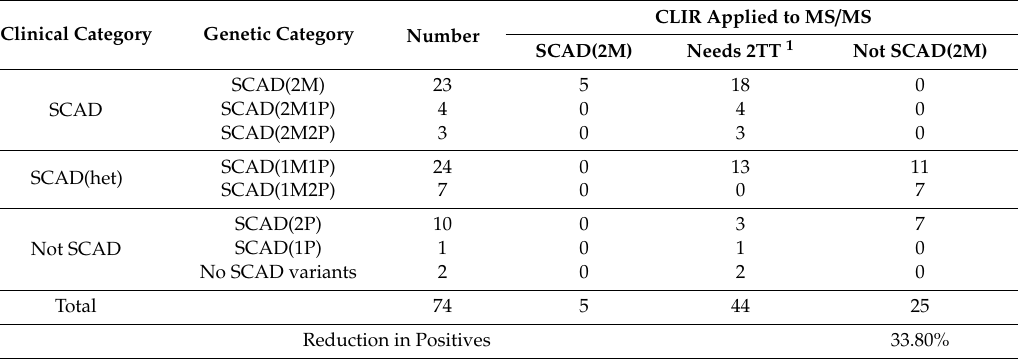
Table 2. Results of the Collaborative Laboratory Integrated Reports (CLIR) SCAD tool applied to the initial MS / MS profile.